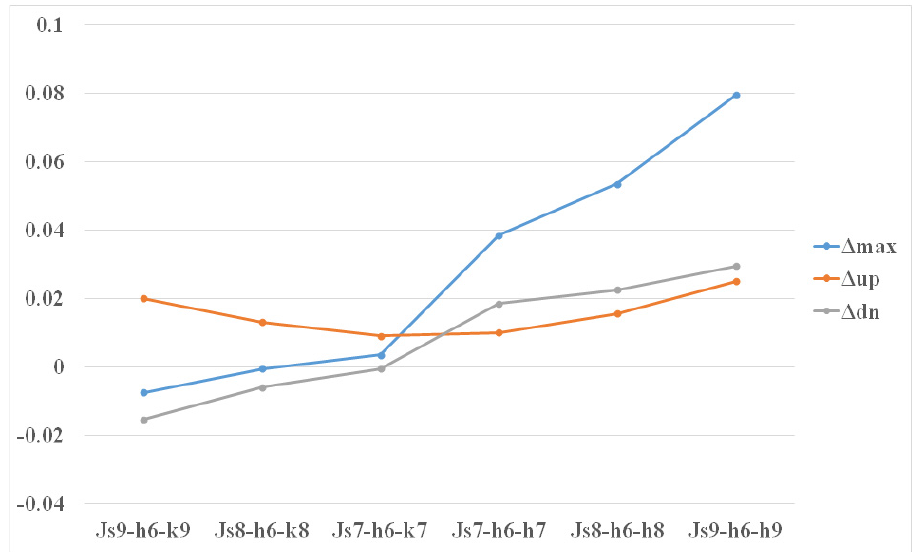
Figure 8. Change of clearances in the engagement when manufacturing the external profile disk by the Js fit.